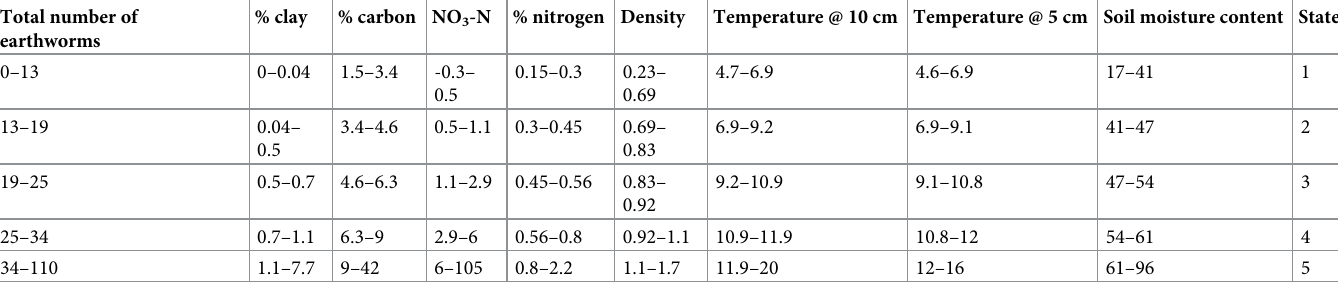
Table 1. The ranges of soil properties associated with each of the 5 bins used in the BBN. Total number of earthworms